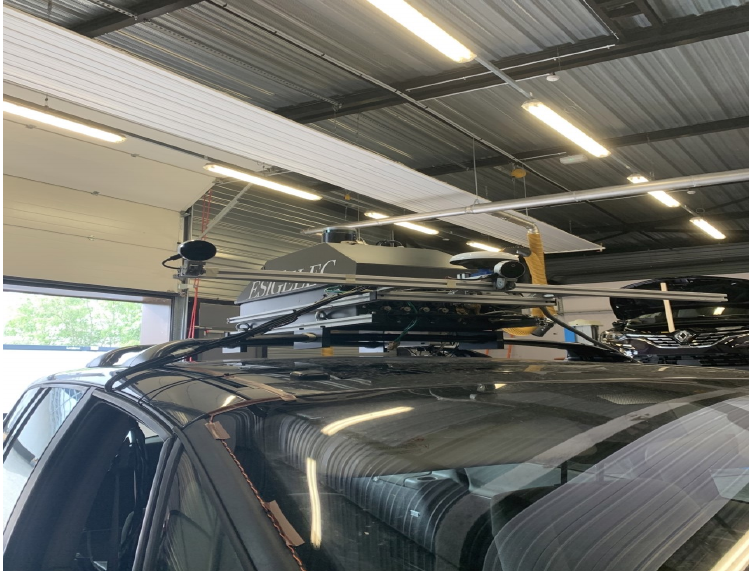
Figure 5. The instrumentation of the camera on the roof of the vehicle. The camera is fixed on a rail just in front of the